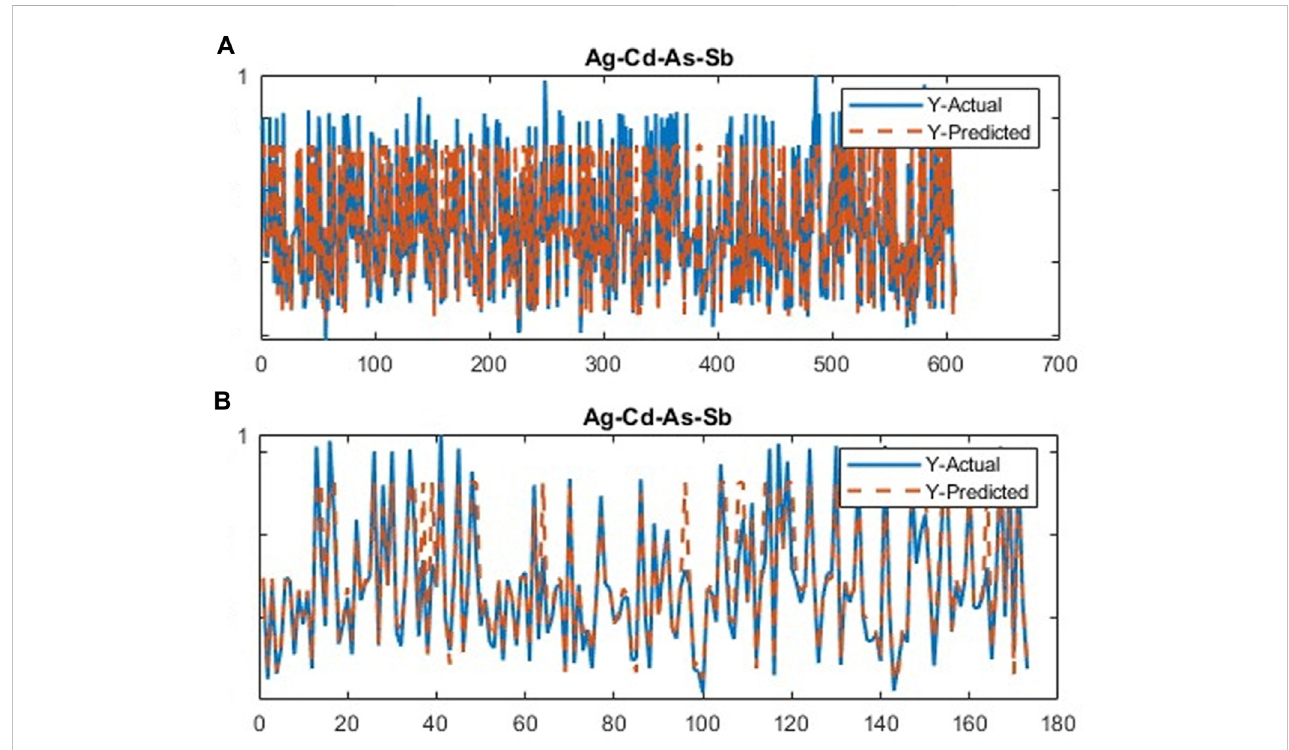
FIGURE 9 Plot of the running CDL network for the third stage of clustering thesecond group of geochemical indicator elements (Ag – Cd – As – Sb); (A) training data and (B) testing data.